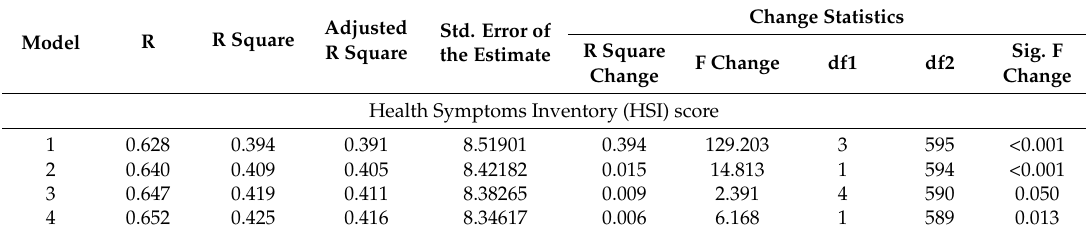
Table 7. Hierarchical analysis of the relationships between influencing factors and health